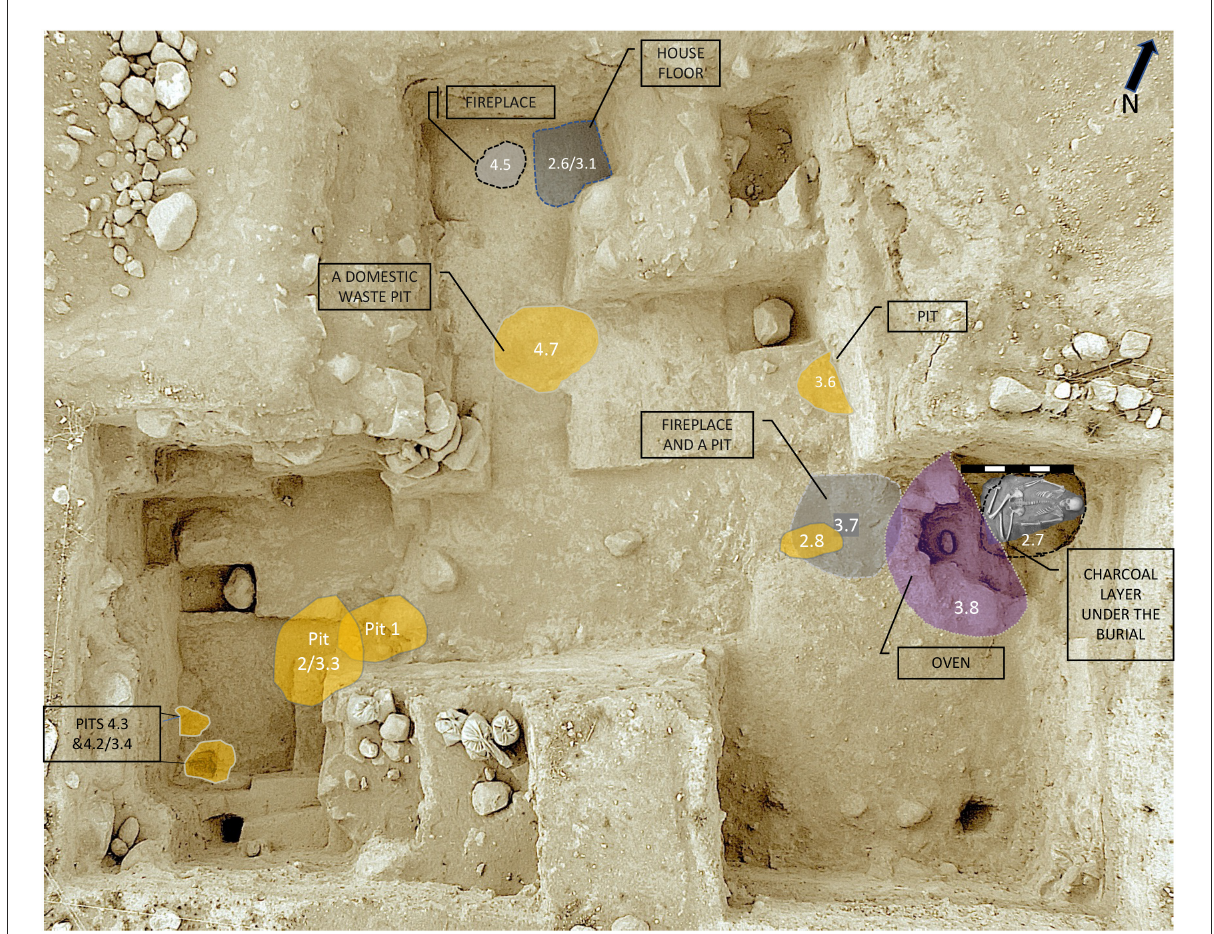
FIGURE2 The aerial photography of Chap II excavation area with marked contexts of archaeobotanical samples as listed in Table 1 (photograph by Kunbolot